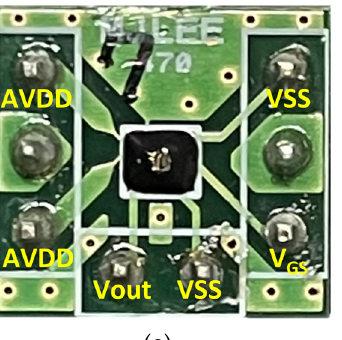
Figure 9. Photograph of the CMOS detector IC for the unit pixel of the proposed array fabricated on the 65 nm CMOS process.